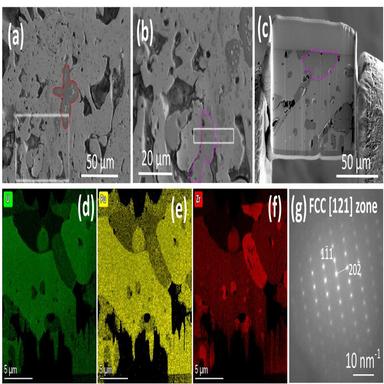
Radial zone 4 has large irregular pores and the matrix is dense with large pure Zr dendrites (outlined by red in a) as well as precipitates larger than the ones in Radial zone 3 (outlined by pink in b-c). STEM-EDS shows the enlarged precipitates are rich in Zr compared to the matrix (d-f). The SAED pattern shows the precipitates are of FCC crystal structure (g).